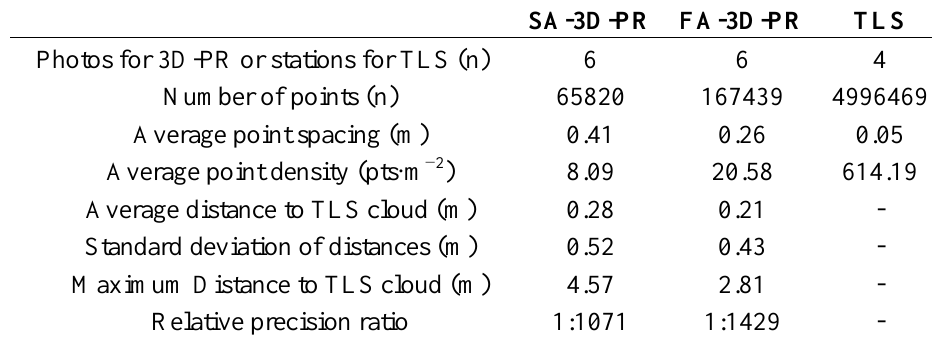
Table 3. Characteristics of the point clouds obtained with the three methods: Semi-Automatic Stereo-Based Scale Invariant Feature Transform (SIFT) method (SA-3D-PR), Fully Automatic 3D Photo-Reconstruction software (FA-3D-PR) and Terrestrial Laser Scanner